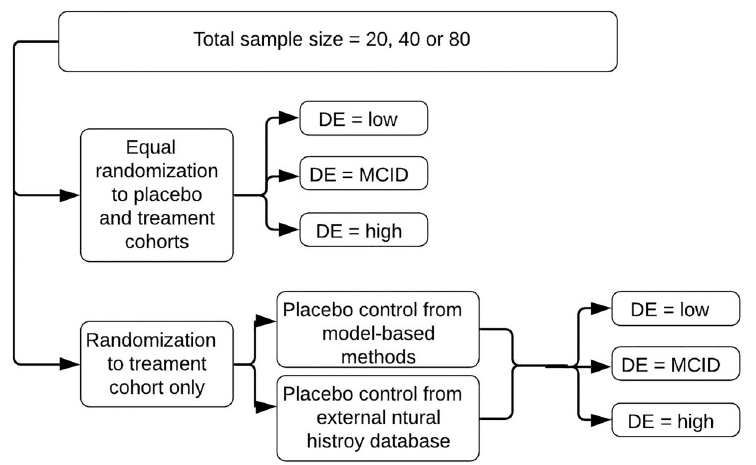
Fig 3. Trial design variations for the simulated short-term DMD trials. Total sample sizes varied between 20, 40 or 80 total subjects. Randomization was either equal to both placebo and treatment cohorts, or to a treatment cohort only. In the case of no placebo cohort present in the trial, controls were obtained from either a model-based prediction or an external natural history database. Drug effect (DE) sizes were defined as low, minimal clinically important difference (MCID), and